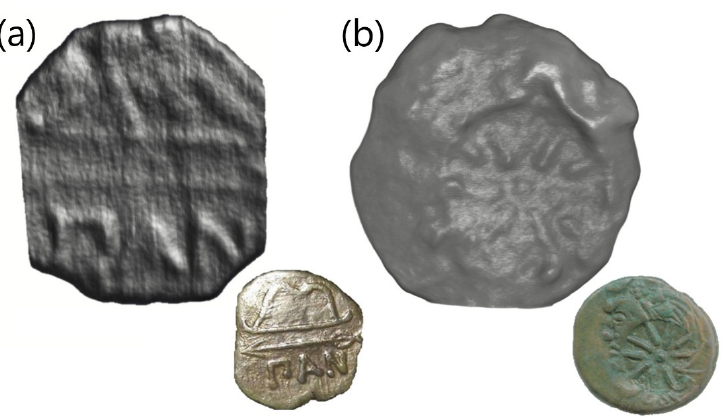
Figure 4. The examples of reconstructed patterns on the surface of several coins from the neutron tomography data. ( a ) The MP468 coin with patterns of a bow, arrow and the inscription “ П AN”. ( b ) The reconstructed view of the “Twenty-ray star” on the MP465 coin. A photo of a similar coin from the catalog [36,37].